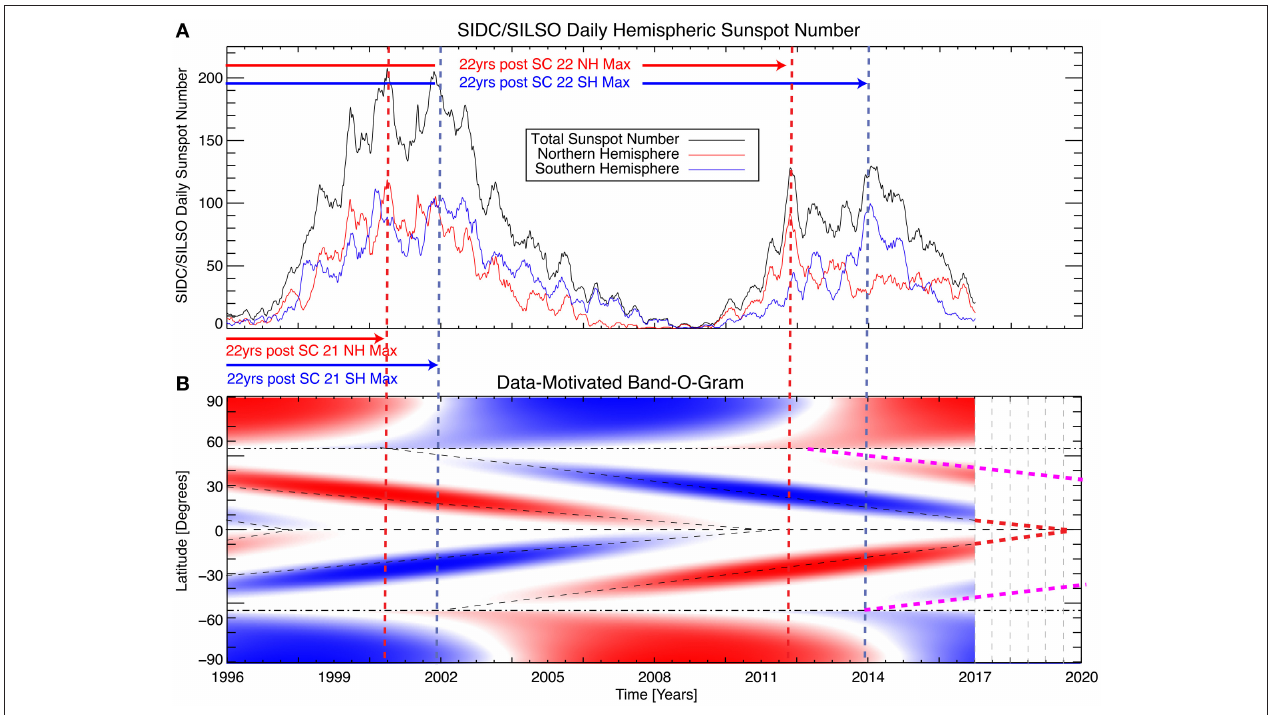
FIGURE 2 | Comparing the evolution of the daily hemispheric sunspot number (A) and a data-inspired representation of activity band polarity and migration (B) . The panel (A) shows the variation of the daily sunspot number in the northern (red) and southern (blue) hemispheres while the total sunspot number is represented in black. The northern and southern hemispheric maxima are indicated as red and blue dashed vertical lines,